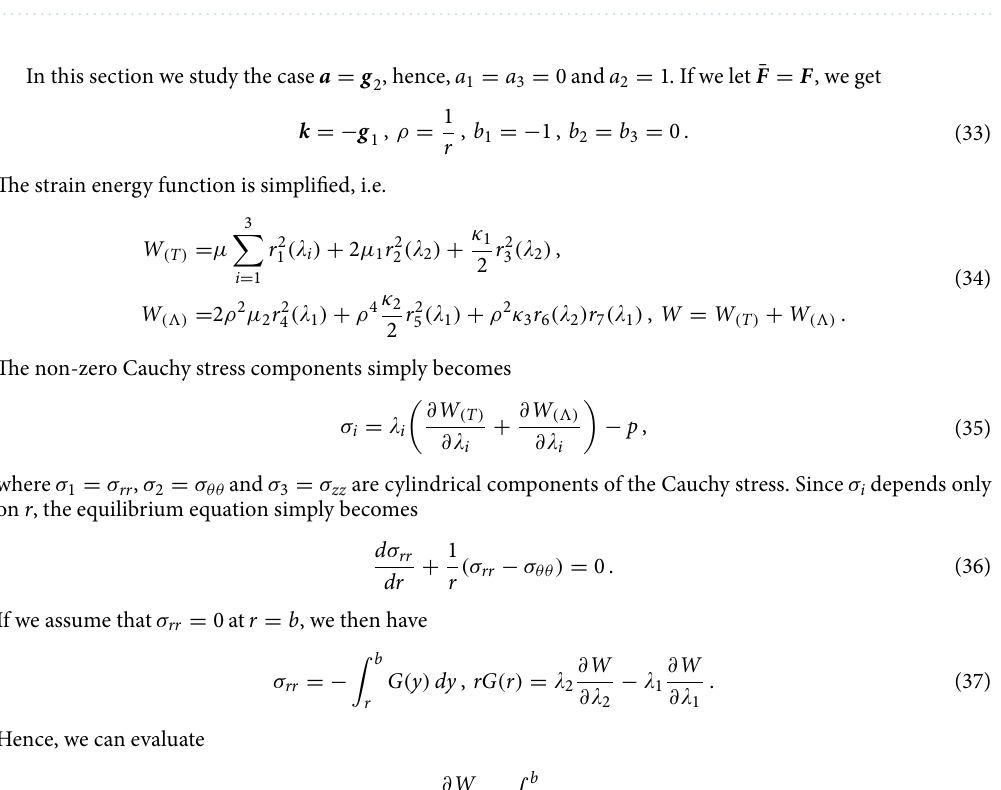
Figure 4. Radial behaviour of stress σ rr . ( a ) Elastic solid with fibre bending resistance. ( b ) Elastic solid with no fibre bending